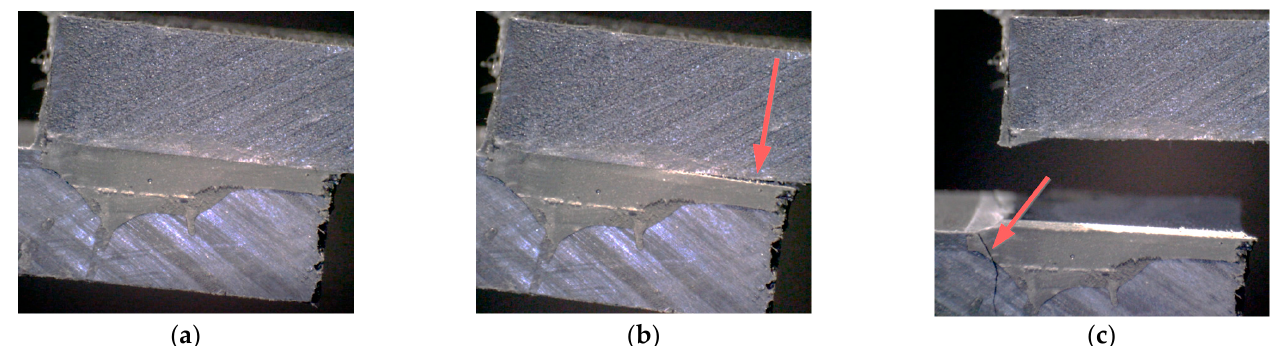
Figure 16. Example of development of substrate failure shown by some specimens: ( a ) undamaged specimen; ( b ) onset and propagation of failure within the adhesive layer ( c ) final failure with substrate cracking.